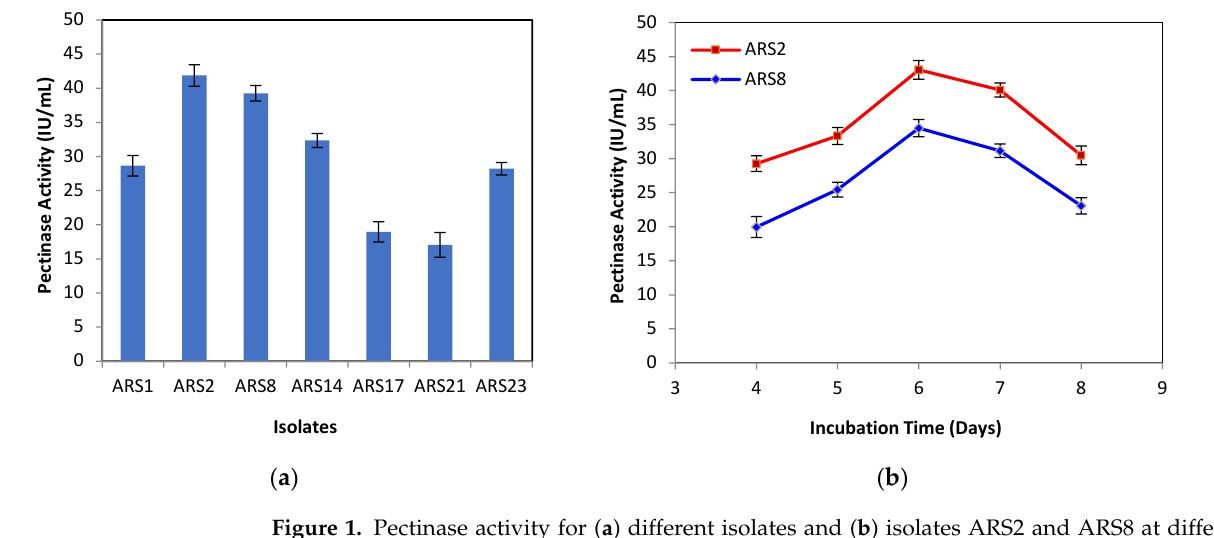
Figure 1. Pectinase activity for ( a ) different isolates and ( b ) isolates ARS2 and ARS8 at different incubation times.